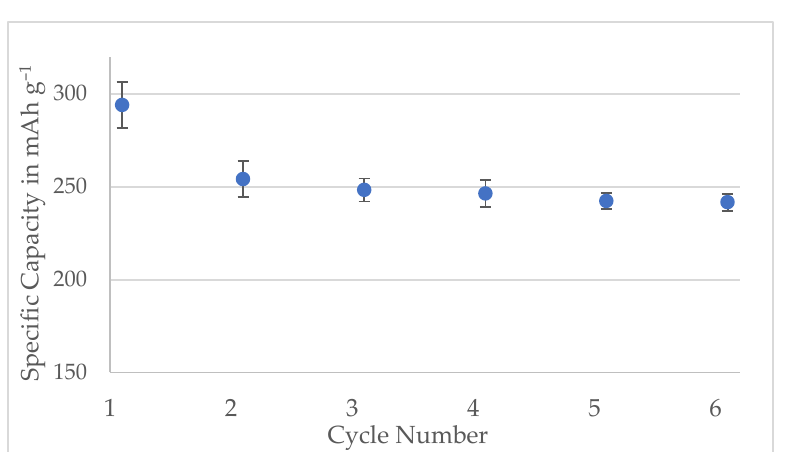
Figure A6. Active material loading of the MTI anodes mixed at 3500 rpm.